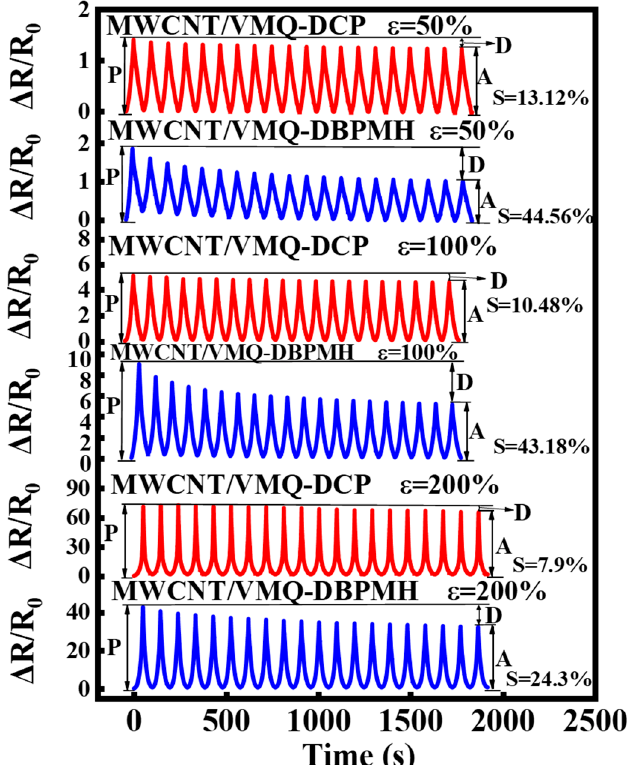
Figure 5. The resistance of the MWCNT/VMQ-DCP composites and the MWCNT/VMQ-DBPMH composites under different levels of cyclic strain and the resistivity changes in the two composites under different strain cycles.